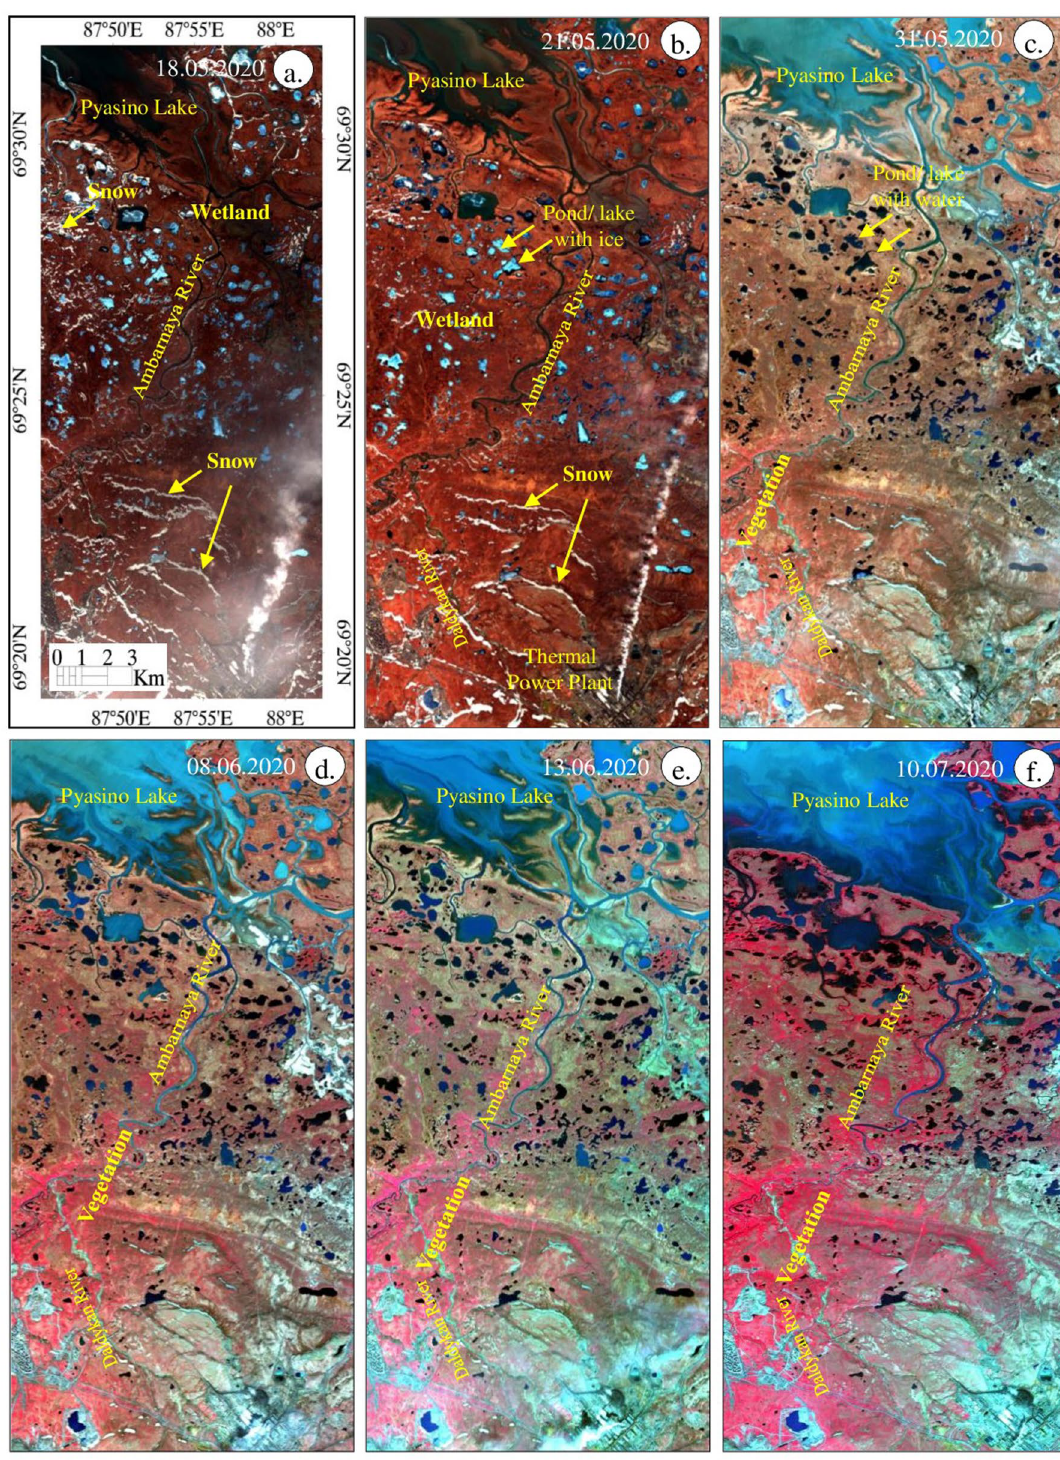
Figure 9. ( a – f ) Sentinel-2 false-color composite images (R:8; G:4; B:3) of May 18 to July 10, 2020 [ENVI 5.5 https ://www.harri sgeos patia l.com; https ://senti nel.esa.int/] showing the presence of snow, water, vegetation, and wetland